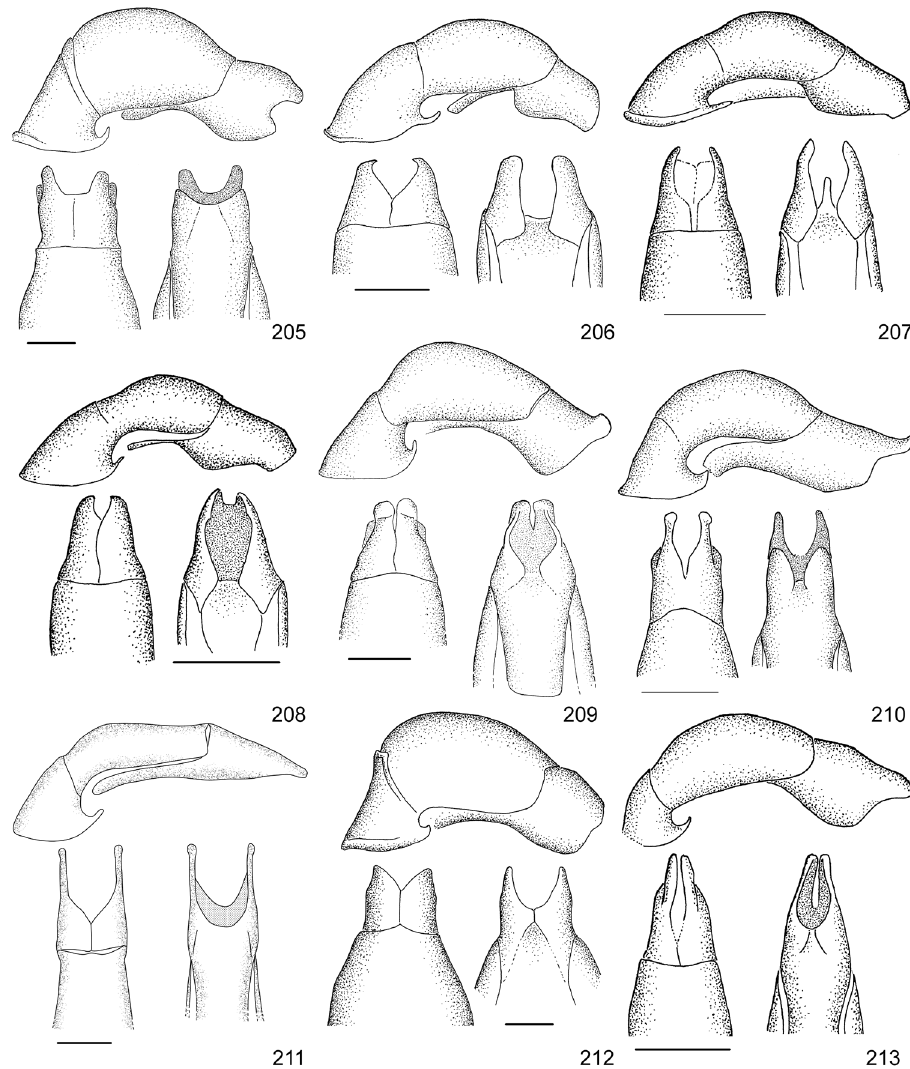
Figures 205–213. Shape of aedeagus, lateral view (top), dorsal view (bottom left), ventral view (bot- tom right) 205 Callistethus lativittis (Dos de Tilaran, Guanacaste, MNCR) 206 C. levigatus (Estación La Casona, Puntarenas, MNCR) 207 C. macroxantholeus (Sector Cerro Cocori, Limón, MNCR) 208 C. microxantholeus (Est. Pitilla, Guanacaste, MNCR) 209 C. mimeloides (La Montura, San José, CEUA) 210 C. multiplicatus (Sector Cerro Cocori, Limón, MNCR) 211 C. nicoya (Estación Quebrada Bonita, Puntarenas, MNCR) 212 C. parapulcher (Estación Pittier, Puntarenas, MNCR) 213 C. pseudocollaris (Estación La Casona, Puntarenas, MNCR). Scale bars: 1 mm. Figs 205–210, 212–213 modified from Filippini et al.